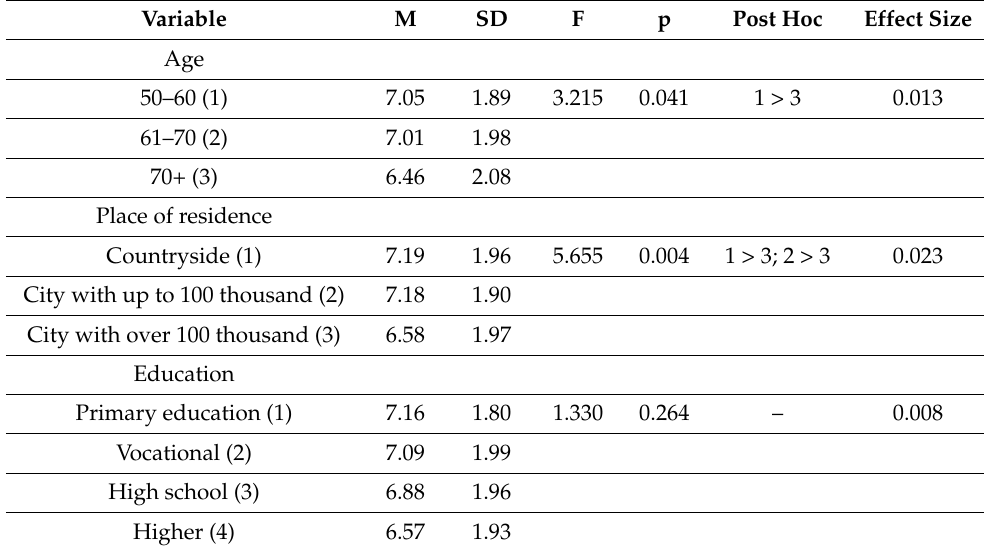
Table 3. Sociodemographic factors modifying activities aimed at obtaining informed consent—results of one-way analysis of